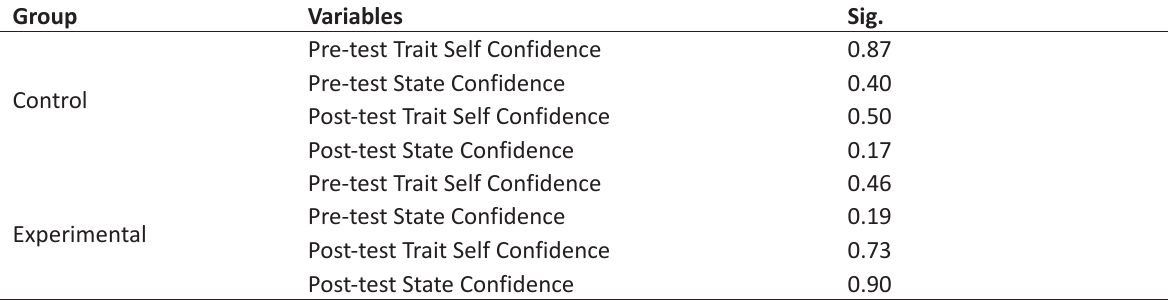
Table 1. Result of Shapiro-Wilk test Group